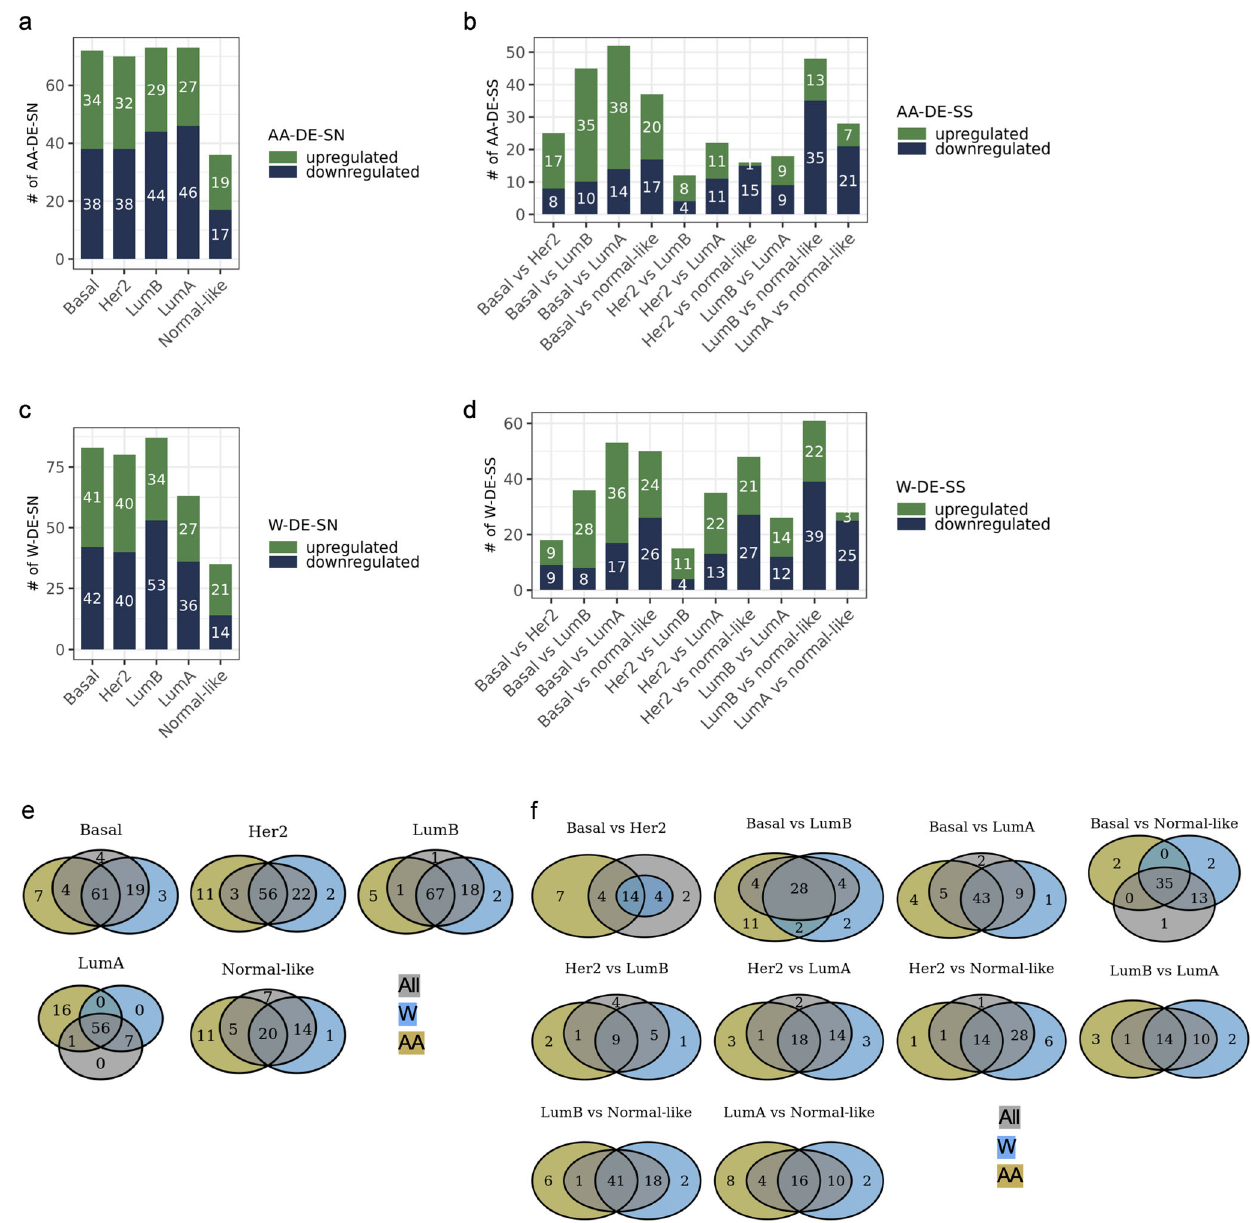
Fig. 4 Identi fi cation of DE-SN or DE-SS in PAM50 subtypes from either AA or W patients. Bar plots depicting the number of DE-SN ( a ) or DE-SS ( b ) in breast cancer samples from AA patients. Similar to a and b , c and d depict the number of DE-SN or DE-SS in breast cancer samples from W patients, respectively. The colors of the bars, the numbers inside the bars, and the axes are as described in Fig. 2. b As in a , but the DE- SS are identi fi ed after comparison of PAM50 subtypes to each other. Intersection among DE-SN ( e ) or DE-SS ( f ) with or without strati fi cation of samples by patient race. e and f Venn diagrams depicting the common DE-SN identi fi ed after comparison between samples of the indicated PAM50 subtype with Normal-adjacent samples or after comparison between samples of the indicated PAM50 subtypes, respectively. Light blue circles represent the DE-SN identi fi ed without strati fi cation by patient race, the light purple circles represent the DE-SN identi fi ed among breast cancer samples from W patients only and the yellow circles represent the DE-SN identi fi ed among breast cancer samples from AA patients